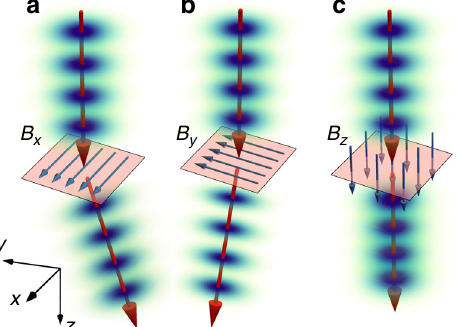
Fig. 2 Scanning electron microscope image and magnetic fi eld distribution of the pillar. a The magnetic pillar dimension is about 220 nm in diameter and 970 nm in height. The pillar was grown by electron-beam-induced deposition. The magnetic fi eld at the center of the pillar reaches values as high as 1.1 T as shown in b . b Magnetic fi eld distribution of a fabricated pillar measured using electron holography when it is tilted by about 60° — note that an in-plane magnetic fi eld induces a transverse Lorentz force (see Fig. 1a, b). The lines are equiphase contours (here drawn every π -phase steps), and correspond to fi eld lines of the magnetic fi